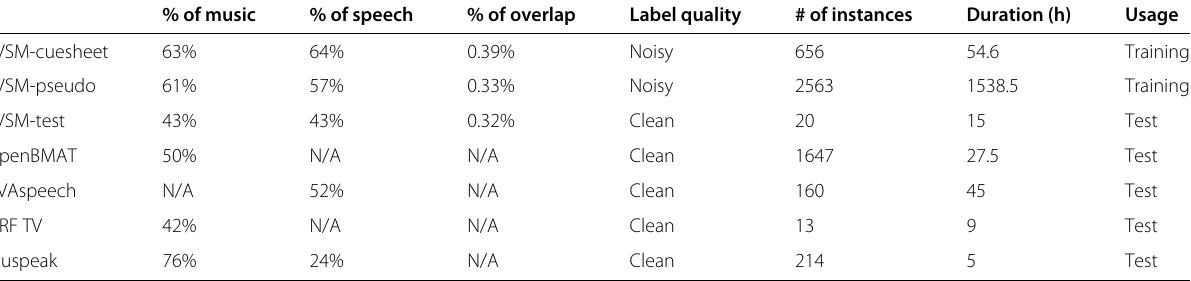
Table 1 Dataset statistics on three subsets of the proposed TVSM dataset and open-sourced datasets with frame-level annotations. Note that % of music/speech is estimated based on the duration labeled as music or speech and the total duration of the audio